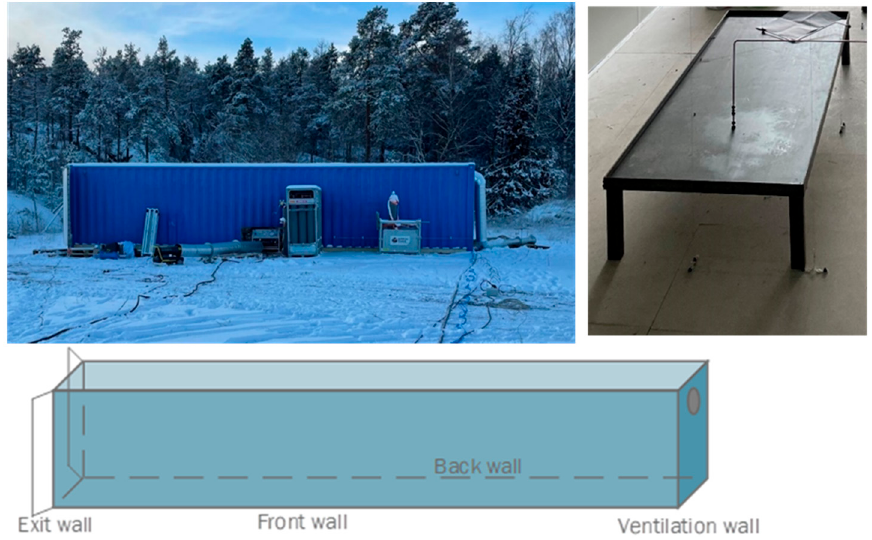
Figure 1. 40 ft ISO container with installed equipment and instrumentation. Inside the container, a steel table (scaled 1:4 of a hydrogen car) with dimensions L × W × H: 1965 × 730 × 250 mm was placed 4500 mm from the ventilation wall. The hydrogen was discharged vertically downwards through the steel table. The nozzle outlet was placed 250 mm above the floor and 5000 mm from the ventilation